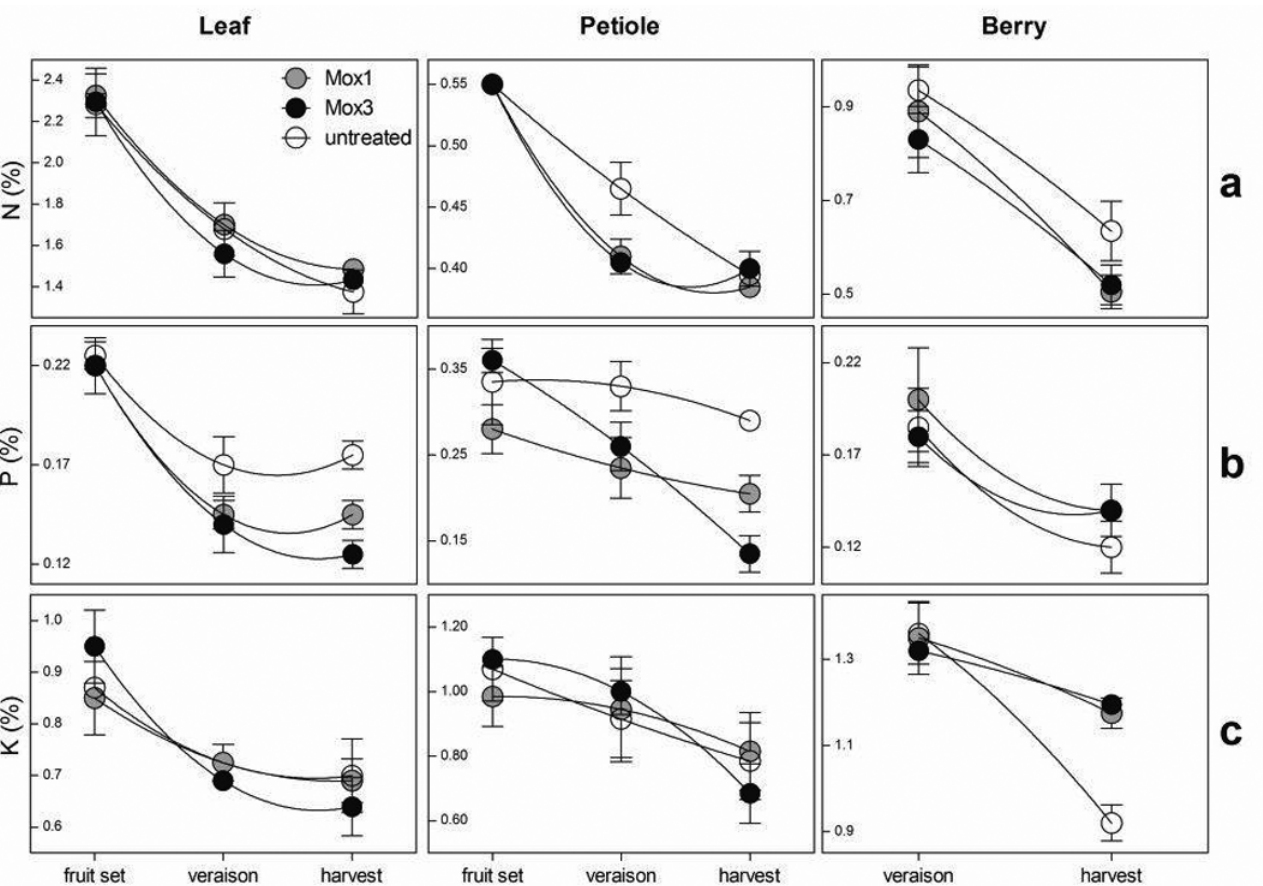
Fig. 1 - Primary macronutrient (N, P, K) concentrations in basal leaf, petiole and berry at fruit set, veraison and harvest in Mo-treated and untreat- ed grapevine plants. Error bars reflect the LSD at p ≤ 0.05. Mox1= Mo treatment in early flowering; Mox3= Mo treatments in early flow- ering, early fruit set and early